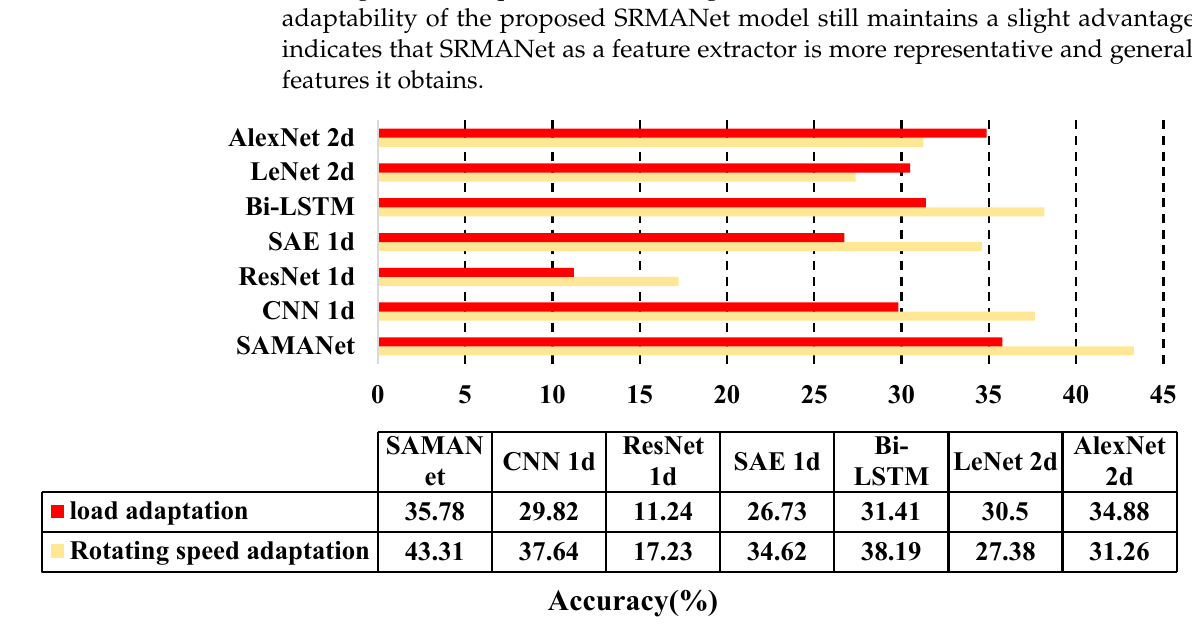
Figure 14. Comparative analysis of DNNs